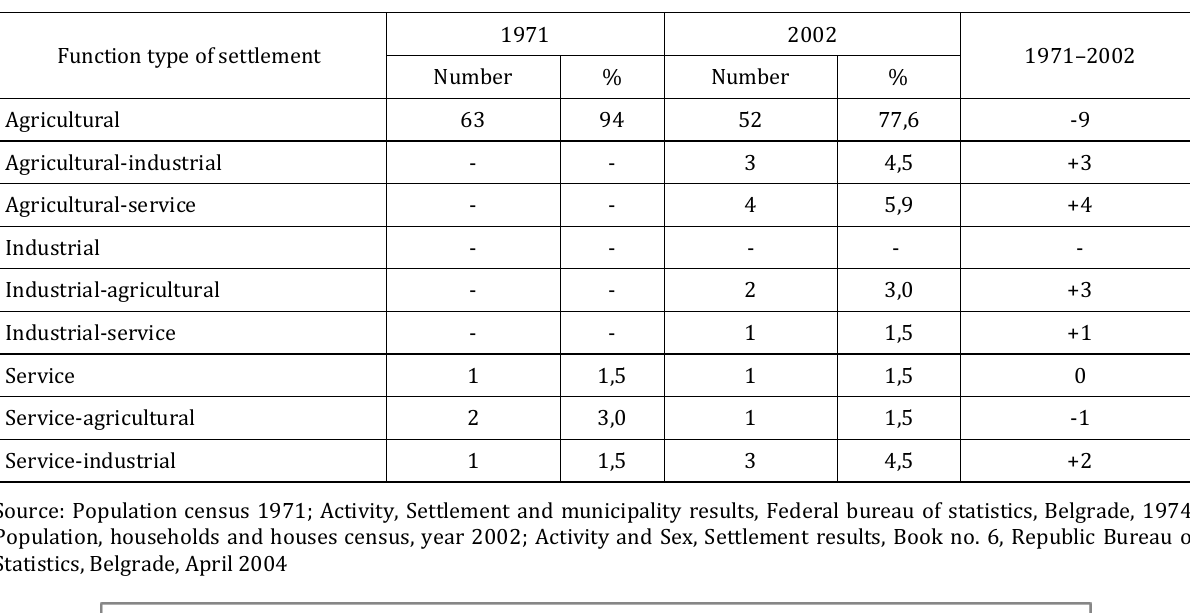
Table 3. Changes of functional types of Albanian settlements between 1971-2002